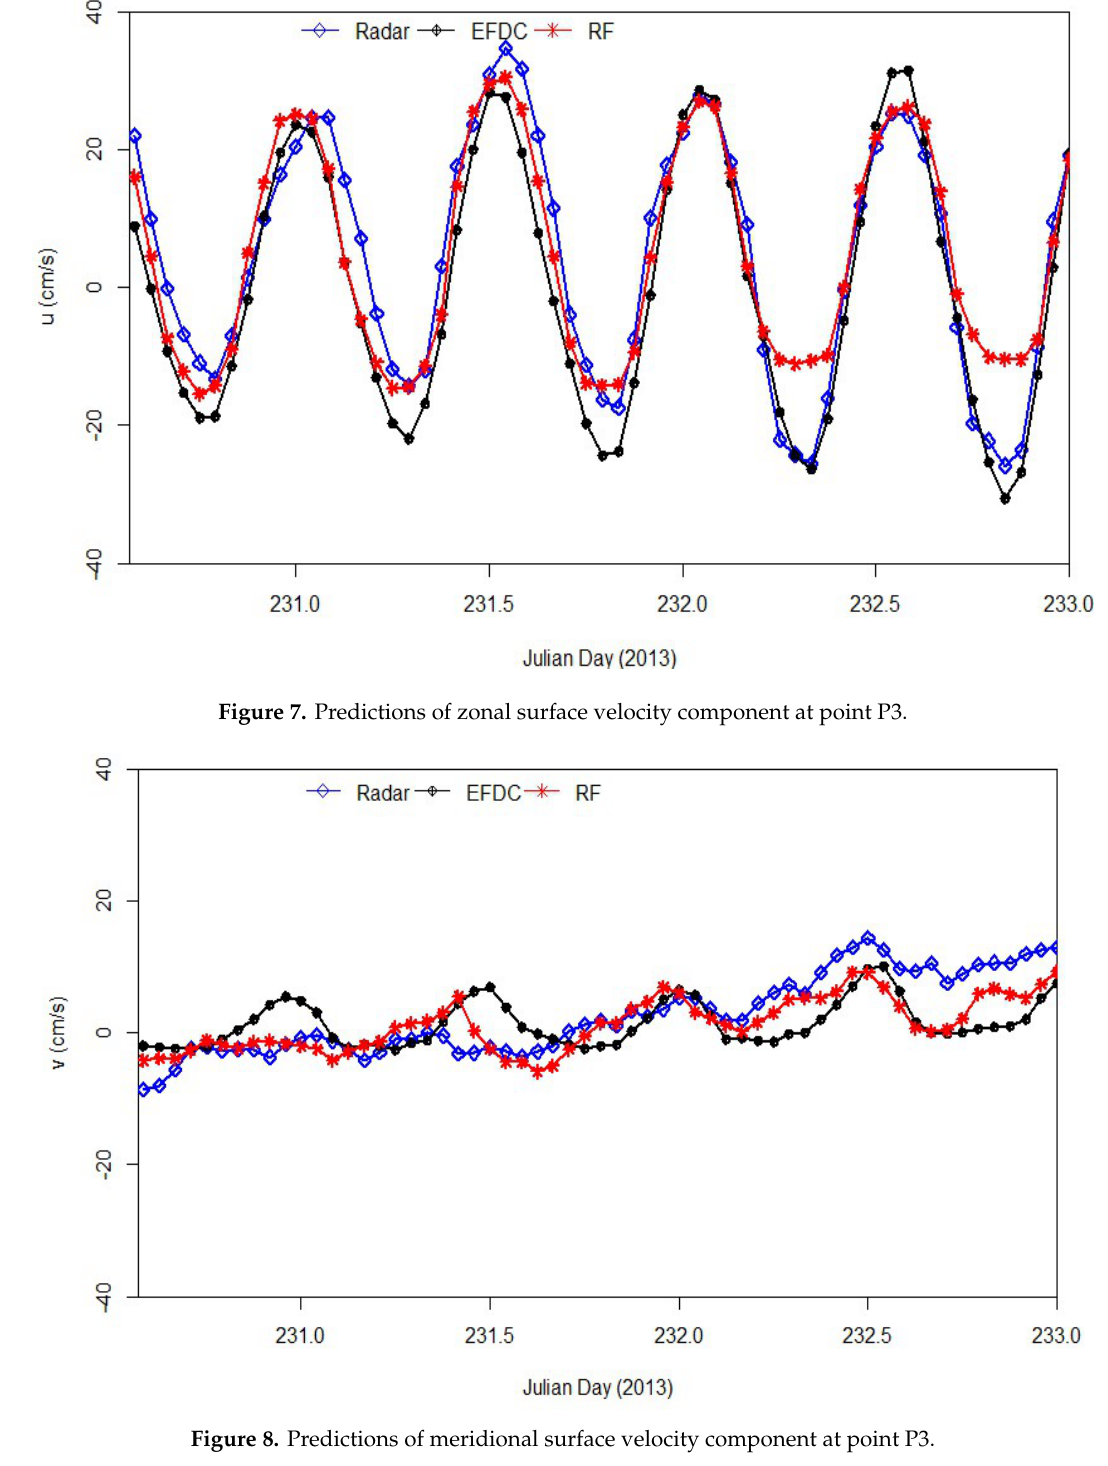
Figure 7. Predictions of zonal surface velocity component at point P3.